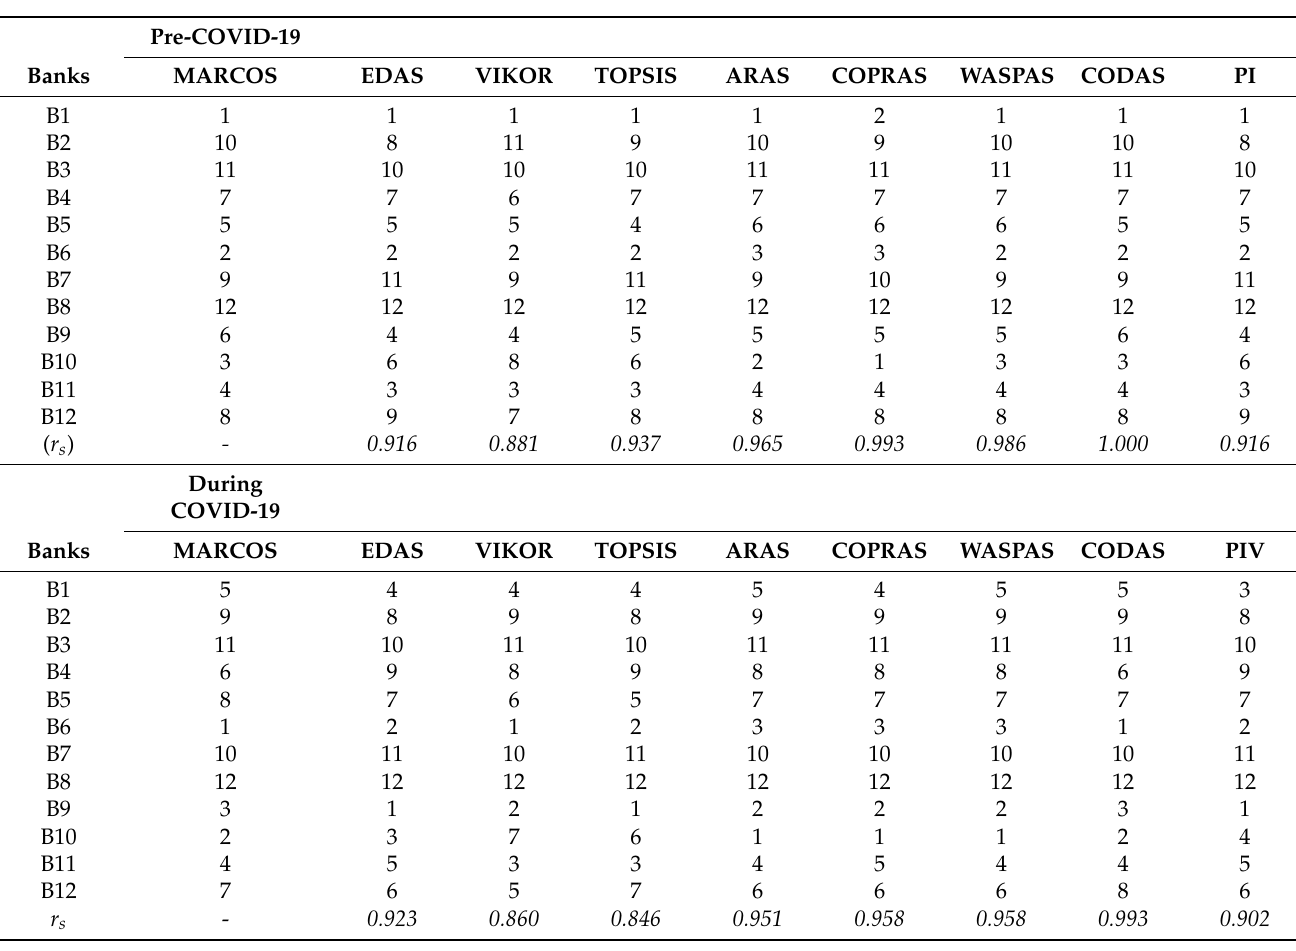
Table 17. Results of the comparative analysis for bank efficiency pre- and during